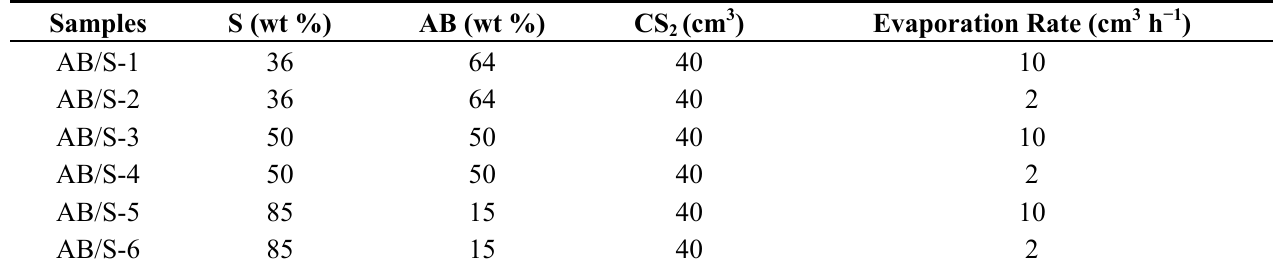
Table 1. Formulas of the composite